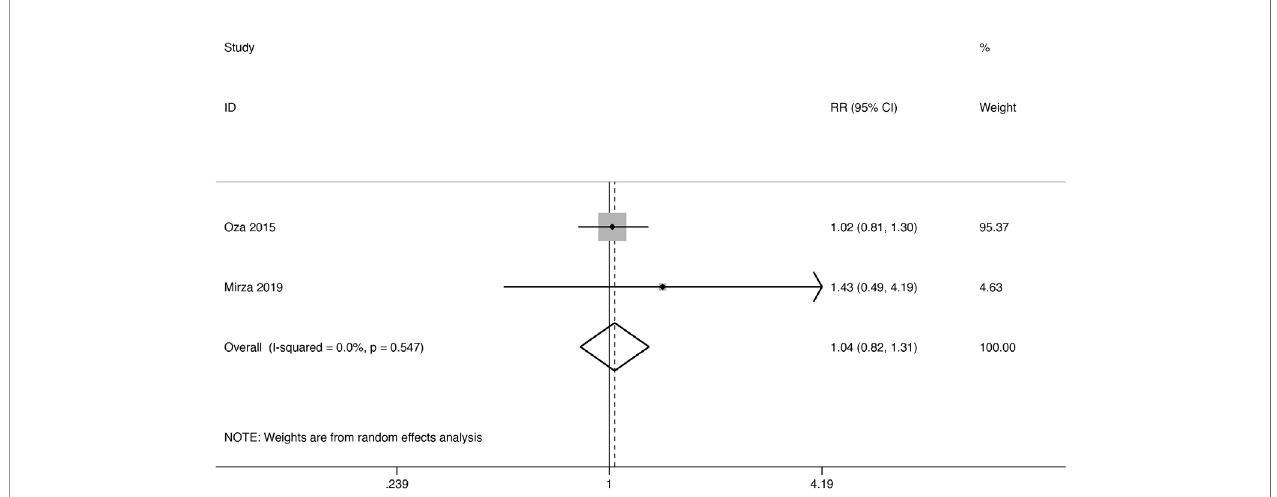
FIGURE 3 | Forest plot of the meta-analysis estimating the relative risk and 95% CI of overall survival for patients assigned to intervention treatment, compared with those assigned to control treatment.